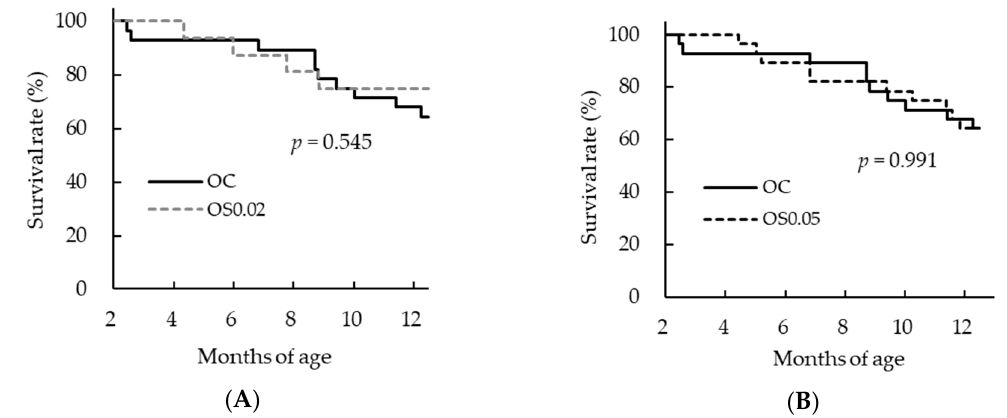
Figure 1. Survival curves in old mice. ( A ) Old control, fed basal diet (OC) vs. old, fed basal diet supplemented with 0.02% sesame lignans (OS0.02), ( B ) OC vs. old, fed diet supplemented with 0.05% sesame lignans (OS0.05). The Survival curves for each group were estimated using the Kaplan–Meier method and di ff erences in survival among the groups were tested using log rank tests with Bonferroni correction. p values less than 0.025 were regarded as statistically significant. There were no significant di ff erences among the groups of aged